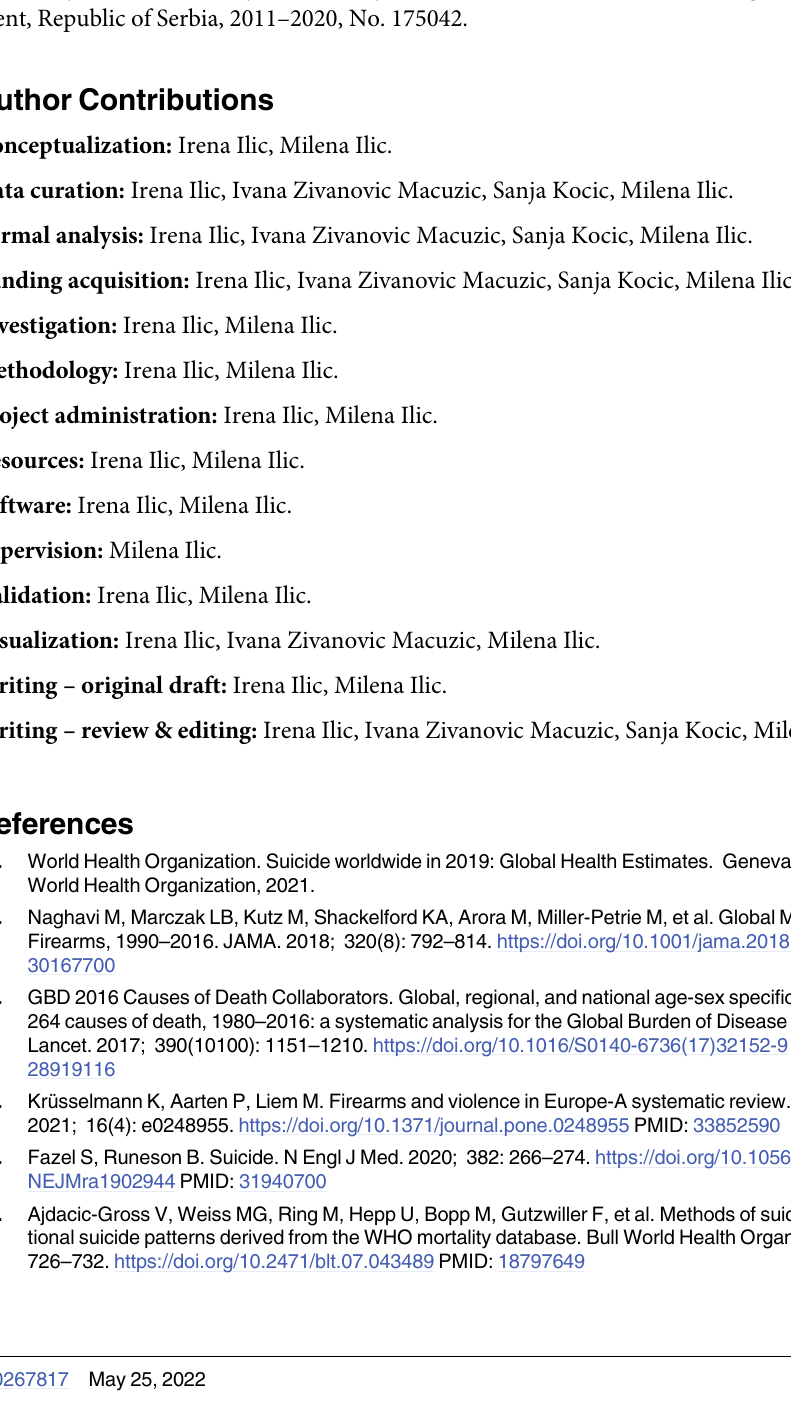
S1 Table. Mortality of suicide by firearm, by location and sex, 1990–2019; a joinpoint anal-